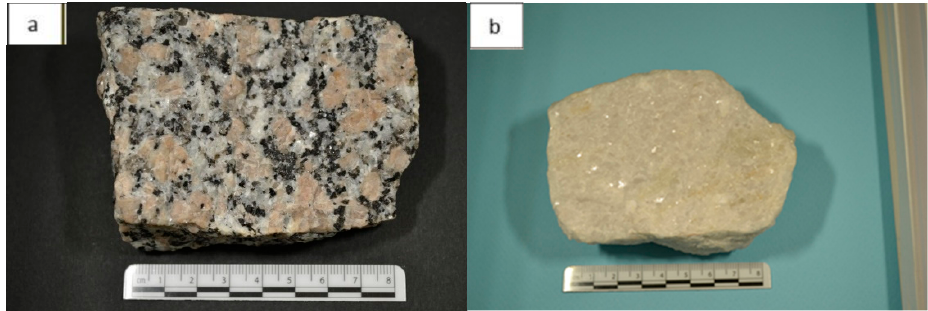
Figure 3. ( a ) Granite; ( b ) marble.